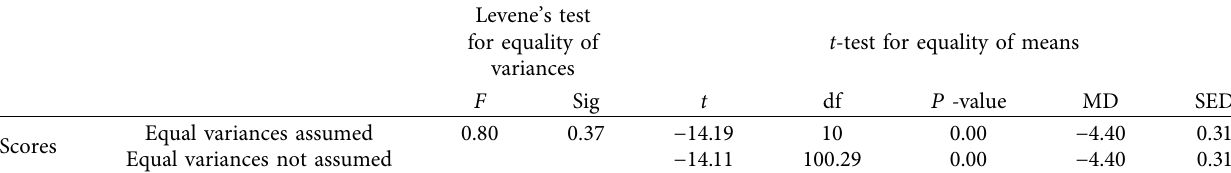
Table 2: Inferential statistics of anxiety questionnaire of both